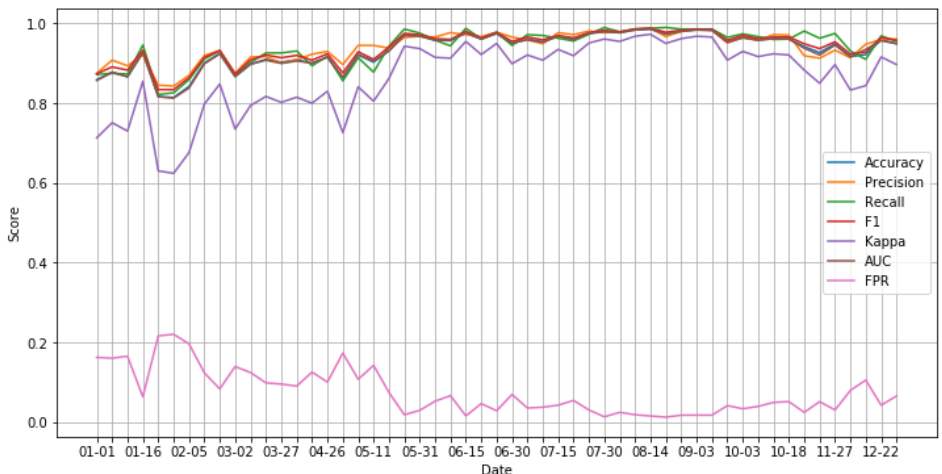
Figure 17. Comparison of the metrics analyzed for the entire time series.